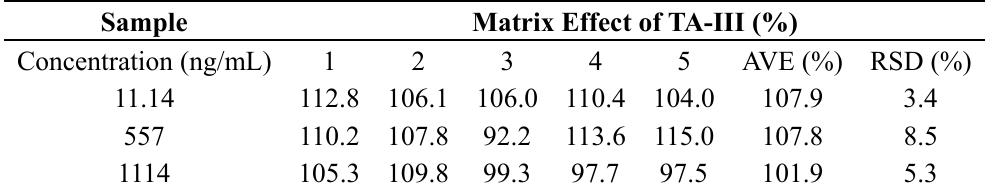
Table 12. Matrix effect of TA-III in rat plasma ( n = 5).